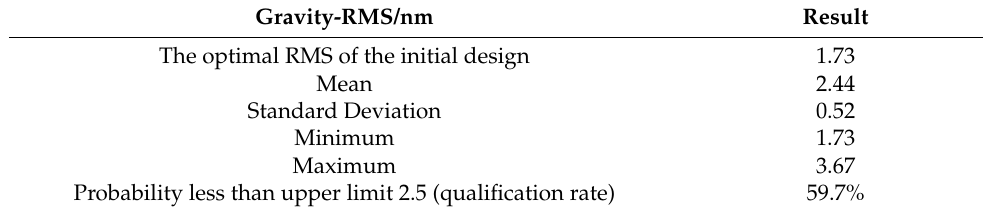
Table 3. The result of Monte Carlo